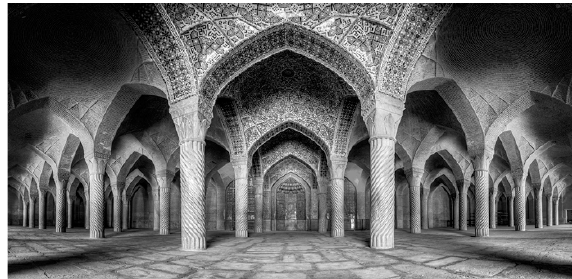
fig. 12. Shabestan of Vakil Mosque (photo by Mohammad reza Domiri Ganji)